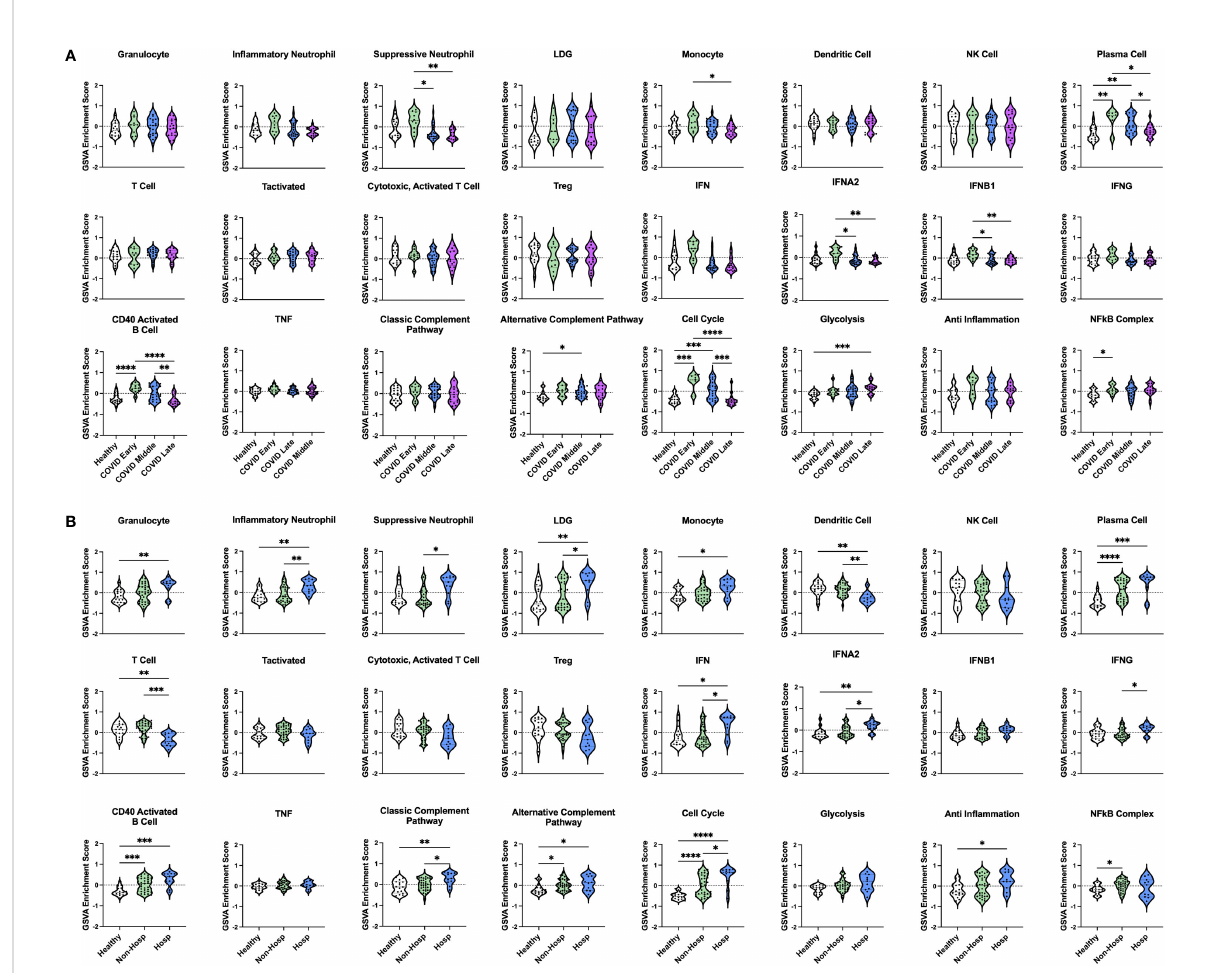
FIGURE 7 Enrichment of immune cell and pathway gene signatures in non-hospitalized and hospitalized COVID-19 patients at different stages of disease. (A) Individual sample gene expression from non-hospitalized COVID-19 patients with early-, mid-, or late-stage disease and healthy controls was analyzed by GSVA for enrichment of immune cell and pathway gene signatures. (B) Individual sample gene expression from non- hospitalized and hospitalized COVID-19 patients and healthy controls was analyzed by GSVA for enrichment of immune cell and pathway gene signatures. Enrichment scores are shown as violin plots. *p < 0.05, **p < 0.01, ***p < 0.001, ****p <